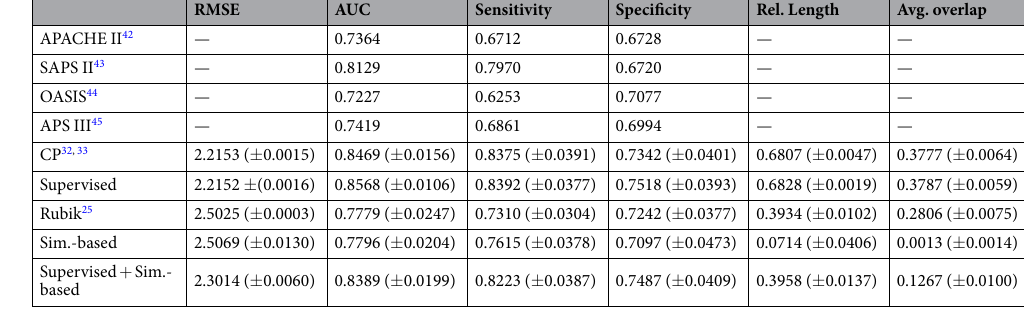
Table 2. Discriminative and distinction power comparison. RMSE, discrimination (AUC, sensitivity, specificity) and distinction (Relative length, Average overlap) with 95% confidence interval of baselines and our proposed models when R = 50. CP = CP decomposition, Supervised = the supervised phenotyping for discriminative power, Sim.-based = the similarity-based phenotyping for distinct power, Supervised + Sim. -based = the final model that incorporates the both supervised and similarity-based